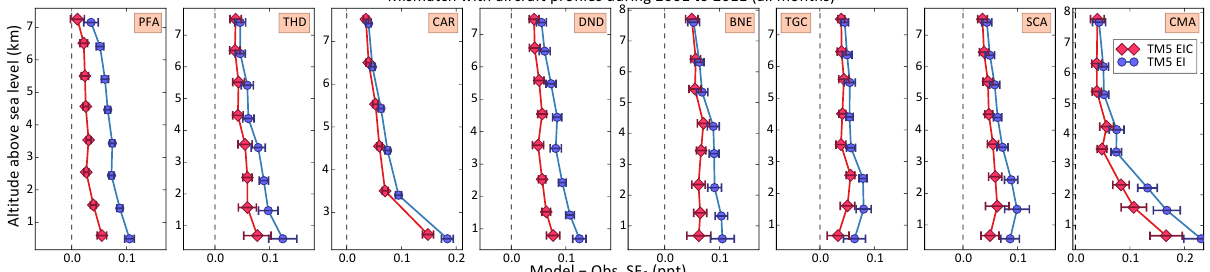
Figure 4. Average difference between observed and modeled aircraft profiles of SF 6 at eight different sites over the continental United States for the period 2001 to 2011 (inclusive). The error bars denote ± 2 σ intervals, where σ is the standard error of the mean difference between each model and observations. The locations of the profiles are identified by three-letter site codes. Details for each site can be found at http://www.esrl.noaa.gov/gmd/dv/site/site_table2.php. Atmospheric mole fractions of SF 6 were simulated using the EI and EIC variants of the TM5 transport model. Three-dimensional initial conditions on 1 January 2000 were based on (a) vertical gradients from the end (1 January 2006) of a previous 6-year TM5 run (with initial conditions which included a specified latitude gradient but no vertical gradient) and (b) the 1 January 2000 smoothed marine boundary layer latitudinal gradient (Masarie and Tans, 1995) derived from SF 6 observations from the NOAA ESRL GGRN. The 1 January 2006 vertical gradients were zonally averaged, scaled back to 1 January 2000 and then added to the observed latitude gradient to create a zonally uniform but vertically and meridionally variable field. SF 6 emissions for the run were based on the spatial emission pattern from EDGAR v4.2 scaled to match the annual increases in SF 6 emissions derived from the observed SF 6 growth rate (assuming no atmospheric SF 6 loss). Measured SF 6 mole fractions used here are available in the